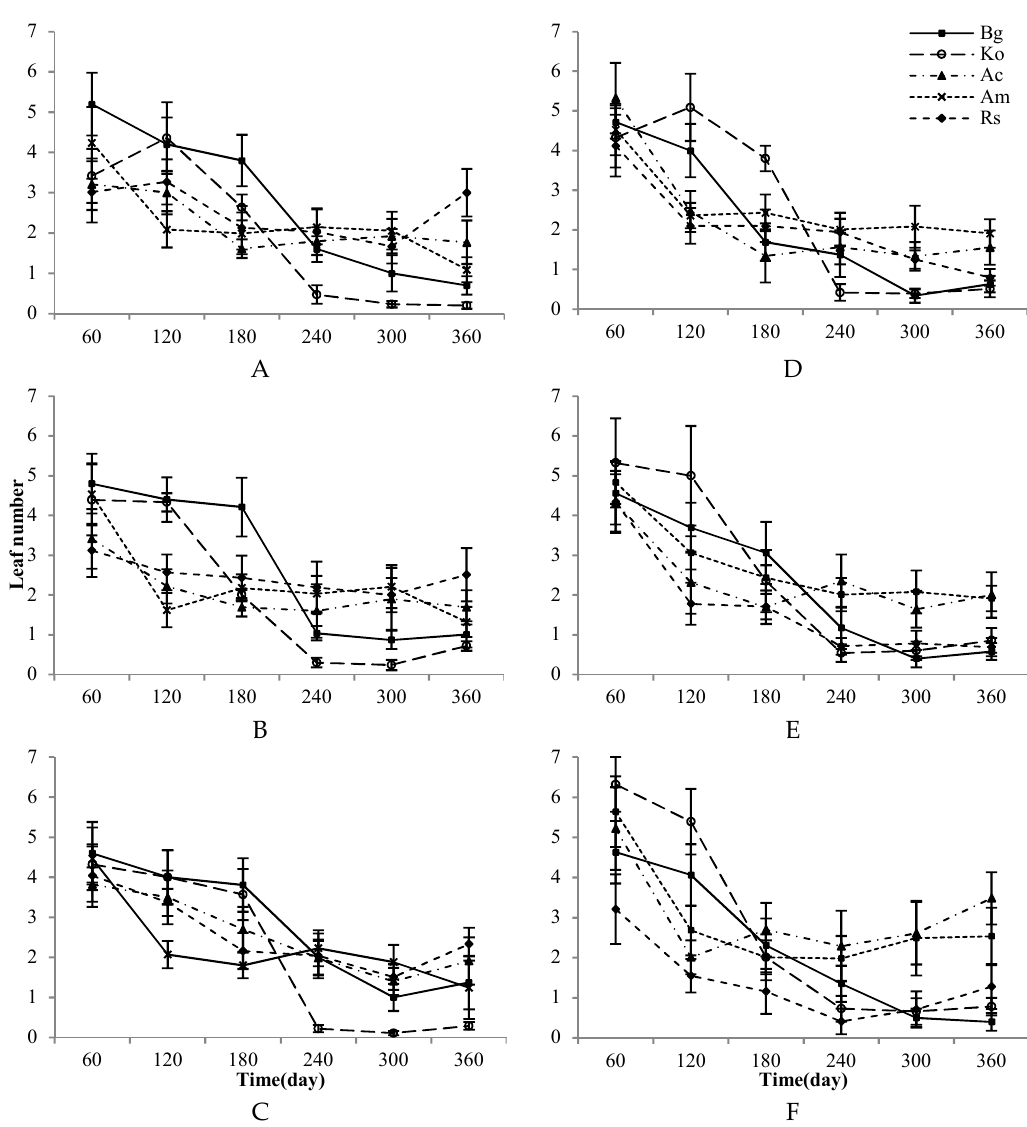
Figure 4. The leaf number of seedlings of the five mangrove species (Bg = Bruguiera gymnorrhiza , Figure. 4. The leaf number of seedlings of the five mangrove species ( Bg = Bruguiera Ac = Aegiceras corniculatum , Ko = Kandelia obovata , Rs = Rhizophora stylosa , Am = Avicennia marina ) gymnorrhiza , Ac = Aegiceras corniculatum , Ko = Kandelia obovata, Rs = Rhizophora stylosa, Am = ( A ) 30% canopy closure and high intertidal elevation, ( B ) 60% canopy closure and high intertidal Avicennia marina ) ( A ) 30% canopy closure and high intertidal elevation, ( B ) 60% canopy elevation ( C ) 90% canopy closure and high intertidal elevation, ( D ) 30% canopy closure and low closure and high intertidal elevation ( C ) 90% canopy closure and high intertidal elevation, ( D ) intertidal elevation, ( E ) 60% canopy closure and low intertidal elevation, ( F ) 90% canopy closure and 30% canopy closure and low intertidal elevation, ( E ) 60% canopy closure and low intertidal low intertidal elevation, ( F ) 90% canopy closure and low intertidal elevation.